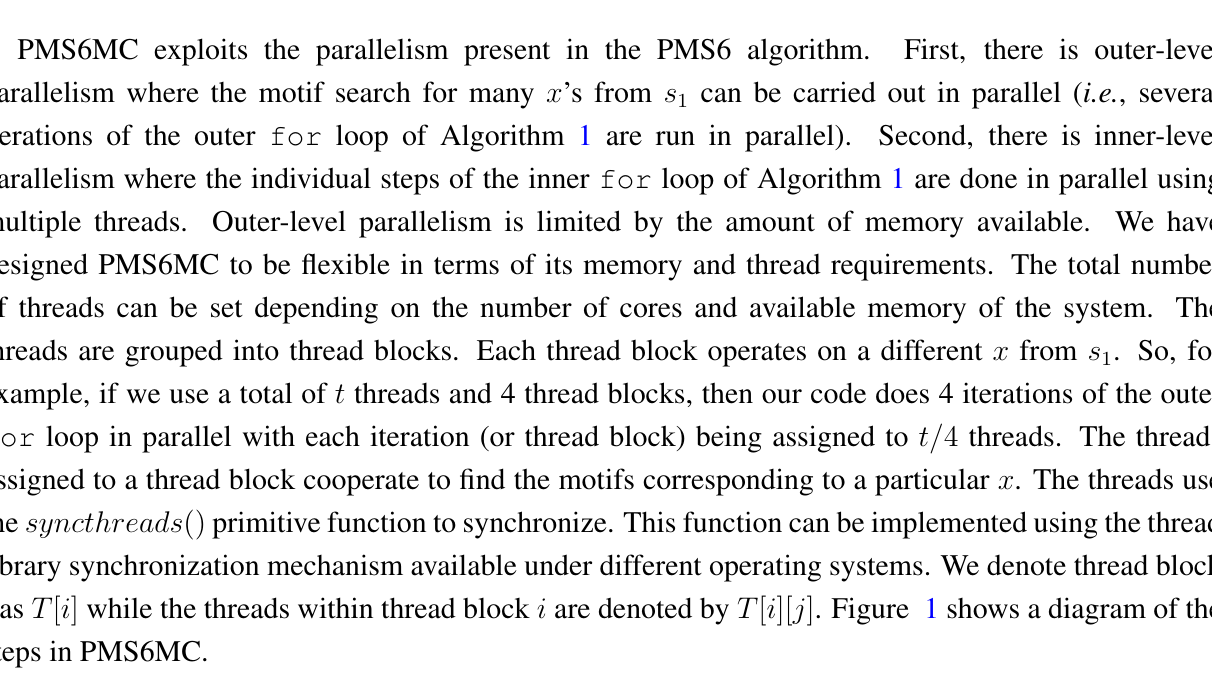
Figure 1. PMS6MC flow